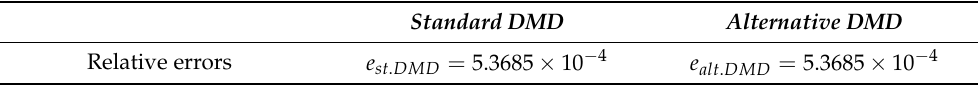
Table 5. Relative errors for DMD reconstructions by Algorithms 1 and 2.